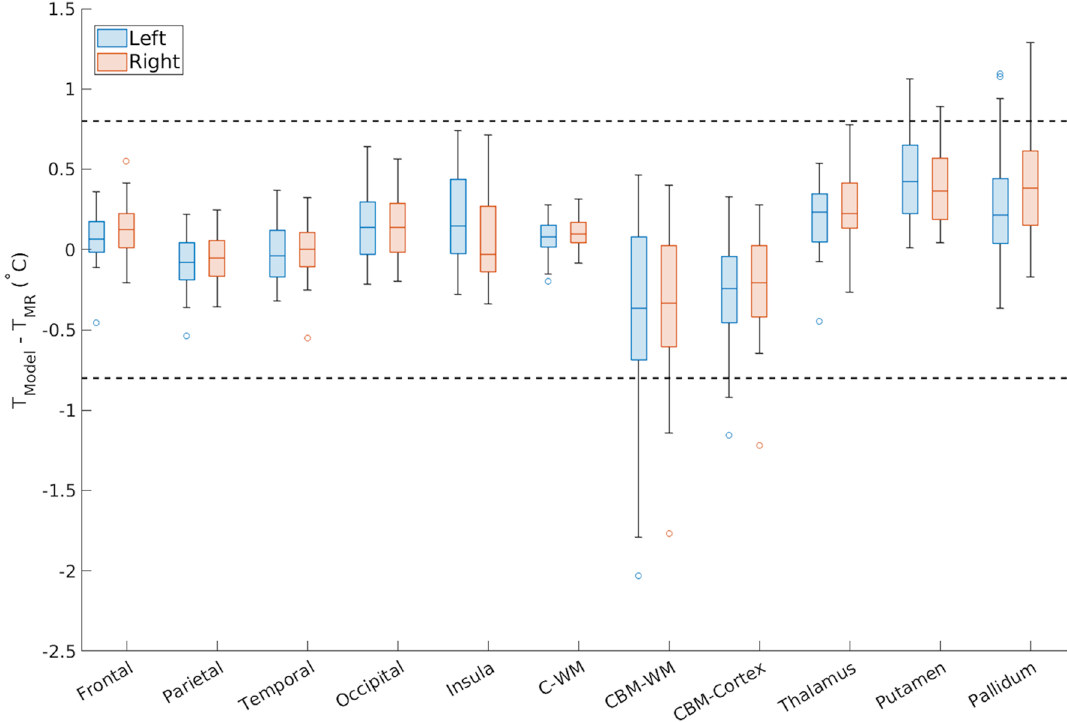
Figure 2. Boxplots of temperature differences between model-predicted and MR-measured temperatures for all subjects. Horizontal dashed lines indicate the agreement threshold of 0.8 °C, and mean differences for all regions were within the threshold. The boxes represent the interquartile range (IQR), the center line represents the median, and whiskers are within 1.5 times the IQR. Outliers are shown as open circles. T Model model-predicted brain temperature, T MR MR-measured brain temperature, Frontal frontal lobe, Parietal parietal lobe, Temporal temporal lobe, Occipital occipital lobe, C-WM cerebral white matter, CBM-WM cerebellar white matter, CBM- Cortex cerebellar cortex. Raw data is shown in Table S1.